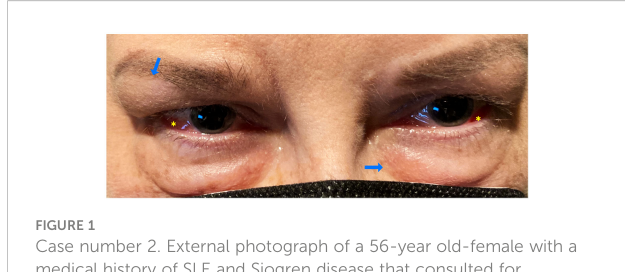
FIGURE 1 Case number 2. External photograph of a 56-year old-female with a medical history of SLE and Sjogren disease that consulted for keratoconjunctivitis sicca, she also complained of polyarthralgias fatigue, oral ulcers and photosensitivity. Ophthalmic exam showed bilateral periorbital edema (blue arrows), and diffuse anterior scleritis (yellow asterisks). At the time of eye presentation, she had been on oral MTX 15 mg weekly combined with 13 mgs of prednisone and belimumab infusions since the past two